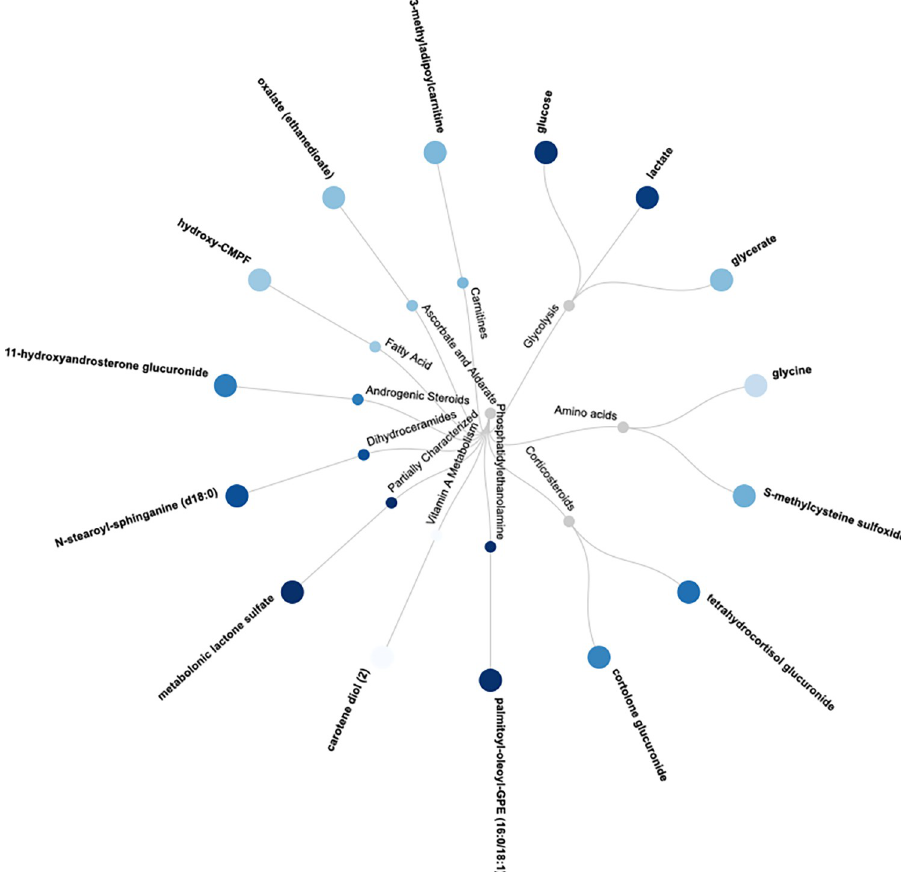
Fig 1. Circular dendrogram of the 15 validated metabolites (and their chemical class) being related to all five metabolic syndrome (MetS) components. A dark blue dot corresponds to a positive relationship vs MetS, while a light blue dot represents an inverse association. The details on the strengths of the relationships vs the MetS components are given in S2 Table, while the strengths of the relationships vs MetS (binary) are given in Table 2.